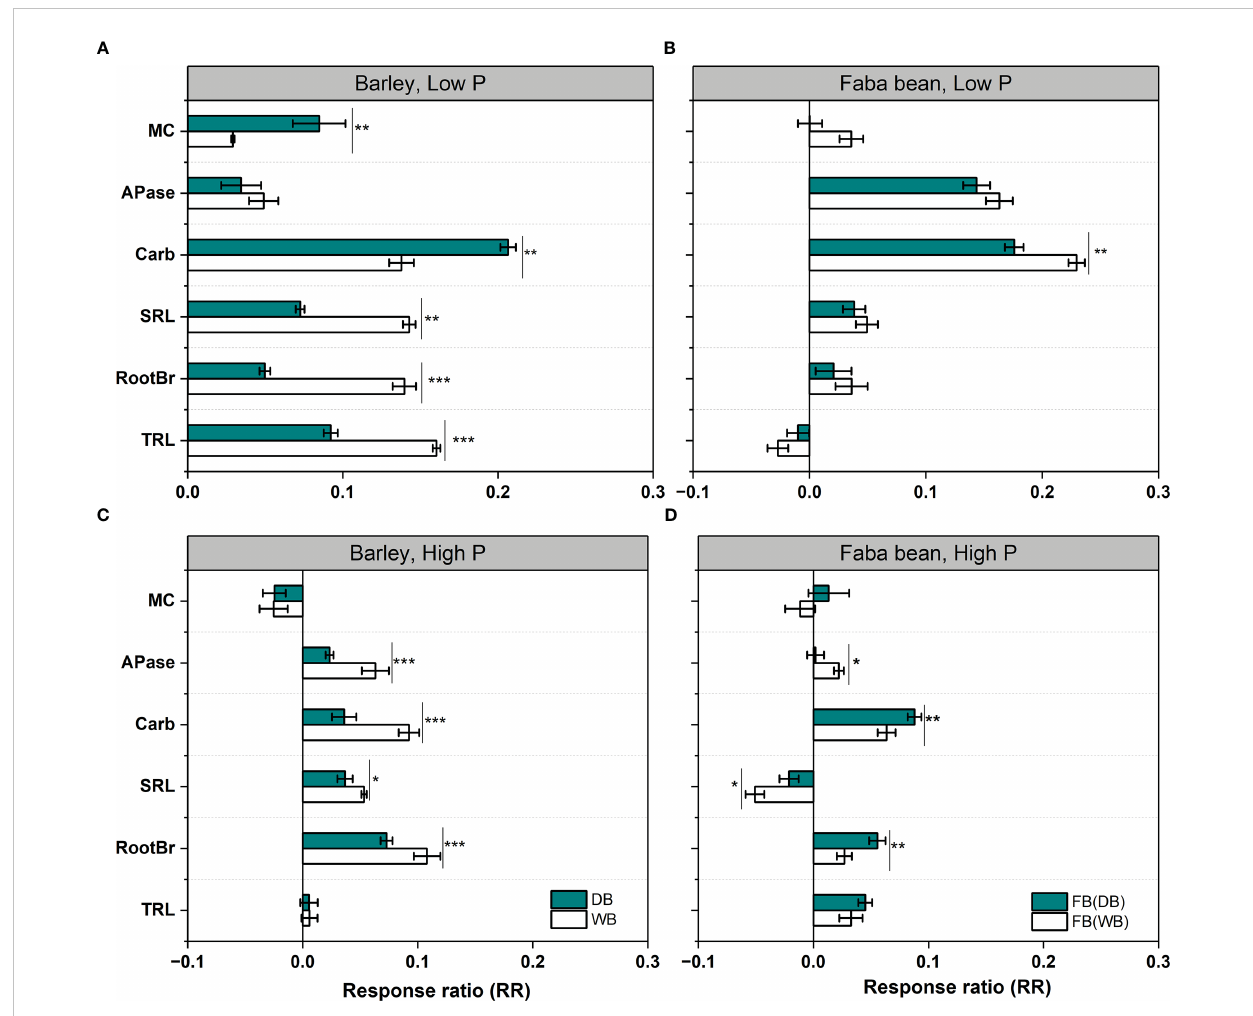
FIGURE 4 The response ratio (RR) of six root functional traits of wild and domesticated barley (A, C) and faba bean mixed with barley (B, D) under low P (A, B) and high P (C, D) . Asterisks denote a signi fi cant difference in the given functional traits between the wild and domesticated barley or faba bean grown with them in the given functional traits based on Student ’ s t -test (signi fi cant level: *, p< 0.05; **, p<0.01; ***, p< 0.001; ns, not signi fi cant). Data are the means + standard deviation ( n = 9). Trait abbreviations: MC, colonization by arbuscular mycorrhizal fungi; APase, acid phosphatase activity; SRL, speci fi c root length; RootBr, root branching intensity; TRL, total root